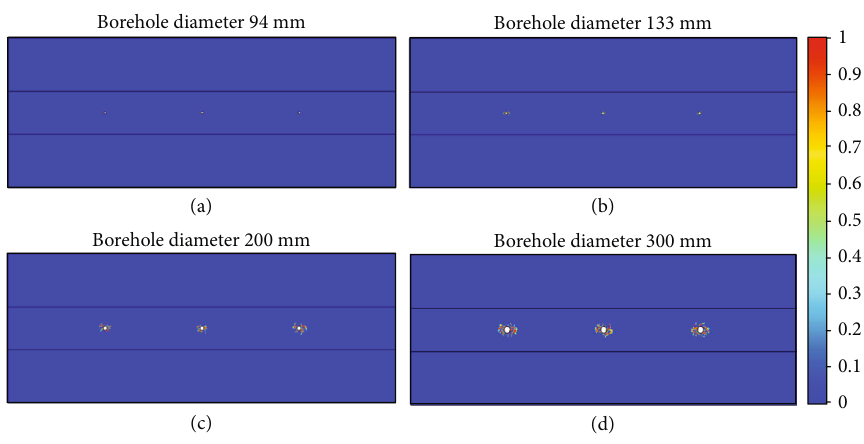
Figure 5: Distribution of damage area in soft coal seam with di ff erent borehole diameters.